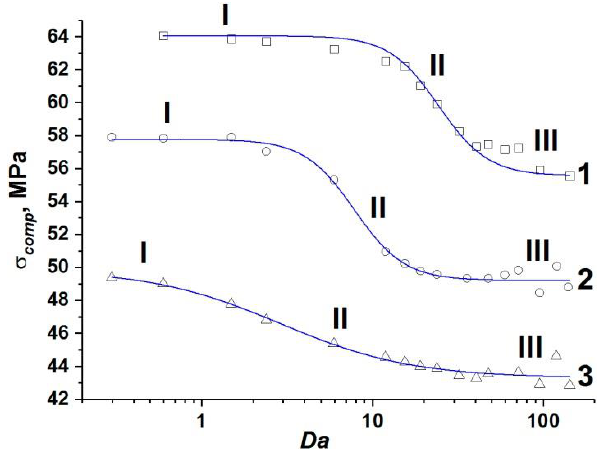
Figure 14. Dependence of the compressive strength of fluid-saturated mesoscale concrete samples with different volume fractions of micropores on the Darcy number Da : 0% (curve 1); 2% (curve 2); 4% (curve 3). Curves 1 and 3 correspond to curves 1 and 2 in Figure 3.